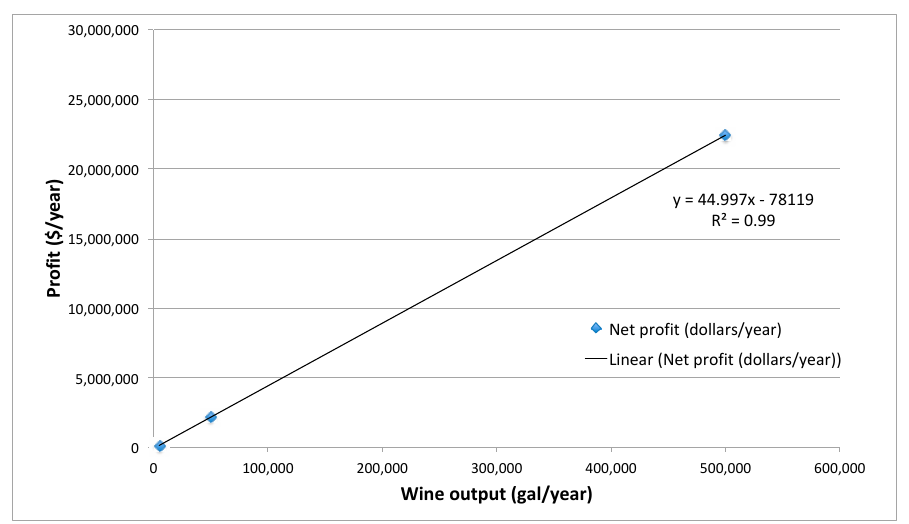
Figure 11. Annual net profit according to scale of operation (showing exponential trendline). Fermentation 2019 , 5 , x FOR PEER REVIEW